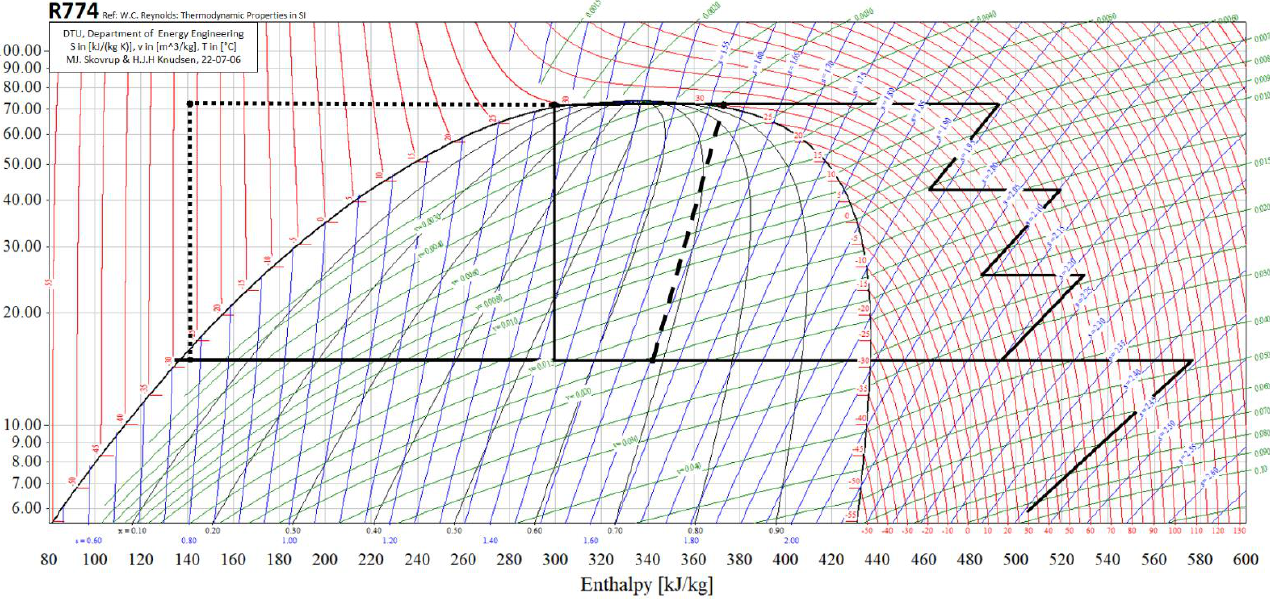
Figure 3. P – H diagram of CO 2 in the open-cycle liquefaction process. The high-end pressure in this case is 72 bar. The black curve shows the open-cycle liquefaction with the control valve. The dashed line shows the expansion with a turbine. The dotted lines show the expansion at −23 °C. Redlines: Isotherms, blue lines: Isentrops, green lines: Isochors.